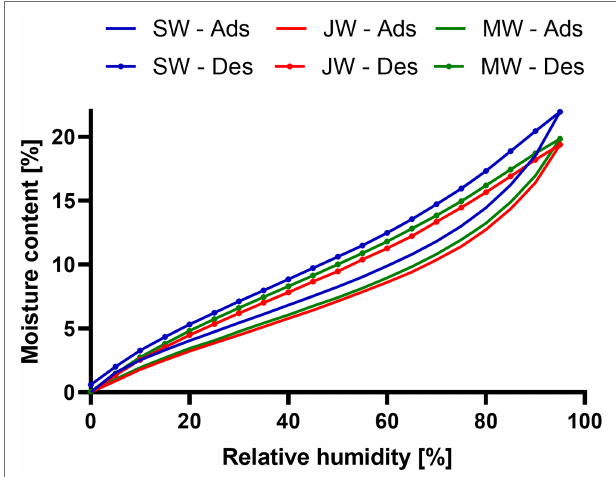
FIGURE 6 | Relationship between relative humidity and wood moisture content. As determined with DVS for Douglas-fir sapwood (SW), Mature heartwood (MW) and juvenile heartwood (JW) of Douglas-fir samples in the second sorption (Sor) and desorption (Des)